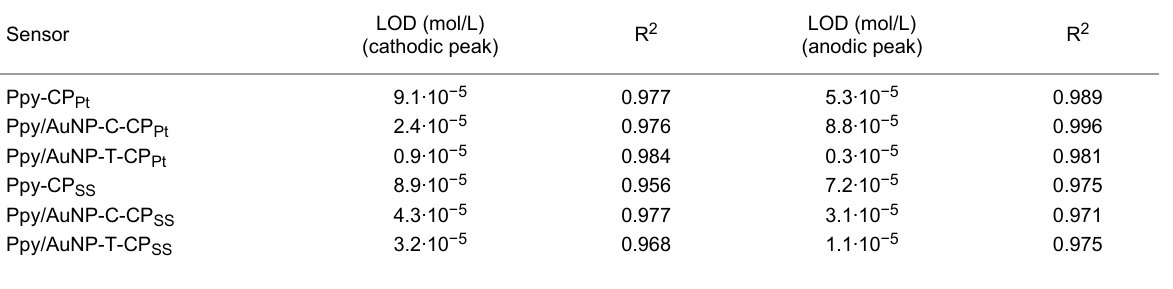
Table 2: LOD, sensitivity and regression coefficients calculated from the anodic and cathodic peaks of catechol.